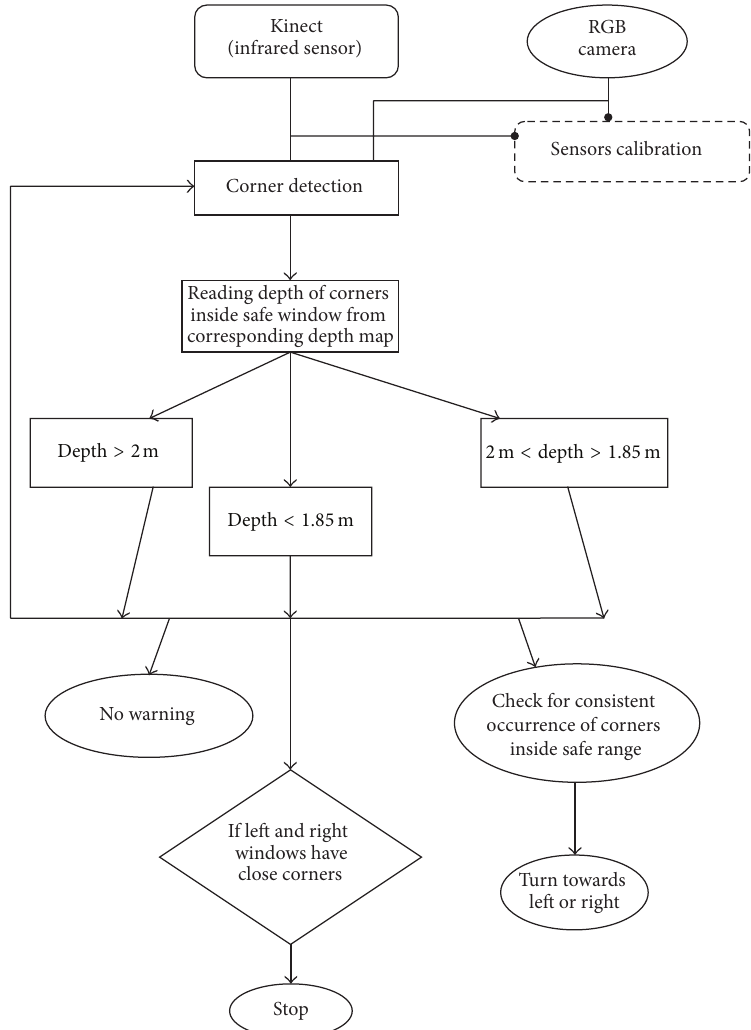
Figure 4: Algorithm describing the conversion of input data into sensible verbal feed for visually impaired person.